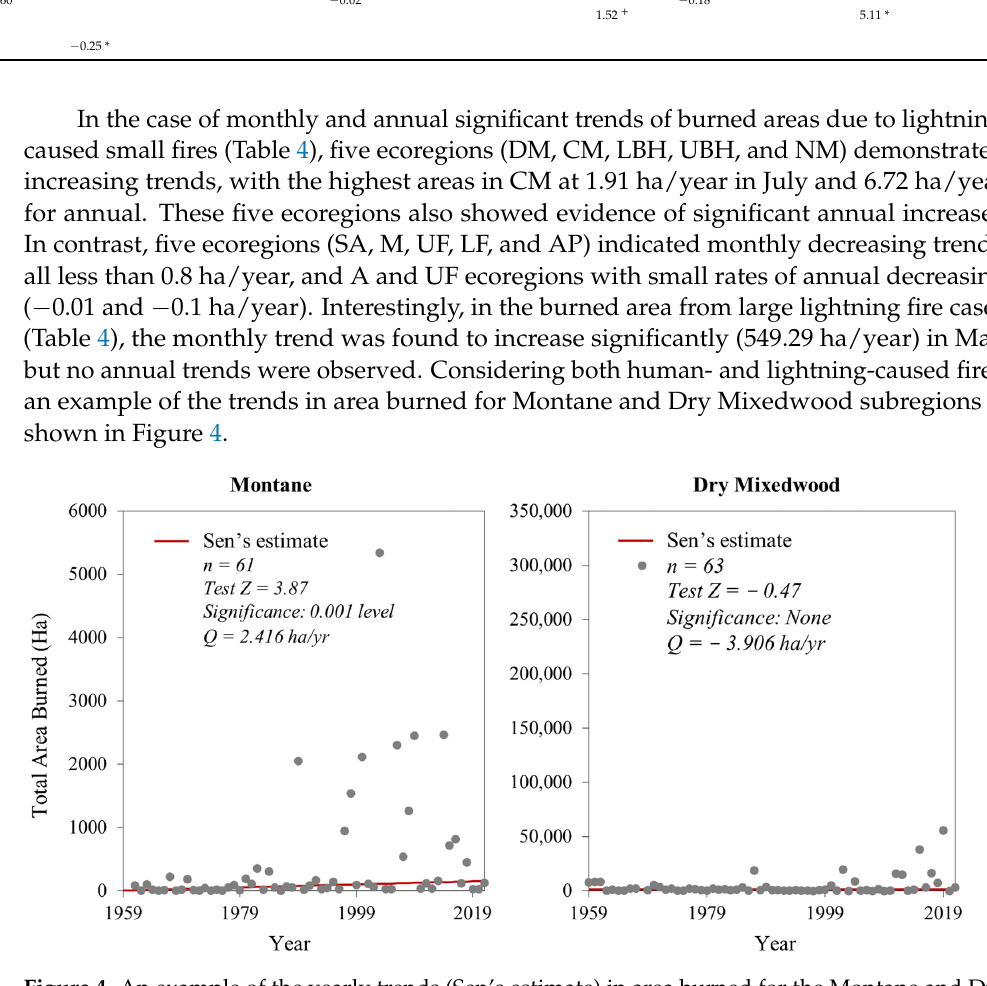
Figure 4. An example of the yearly trends (Sen’s estimate) in area burned for the Montane and Dry Mixedwood subregions over the period 1959 ‒ 2021.